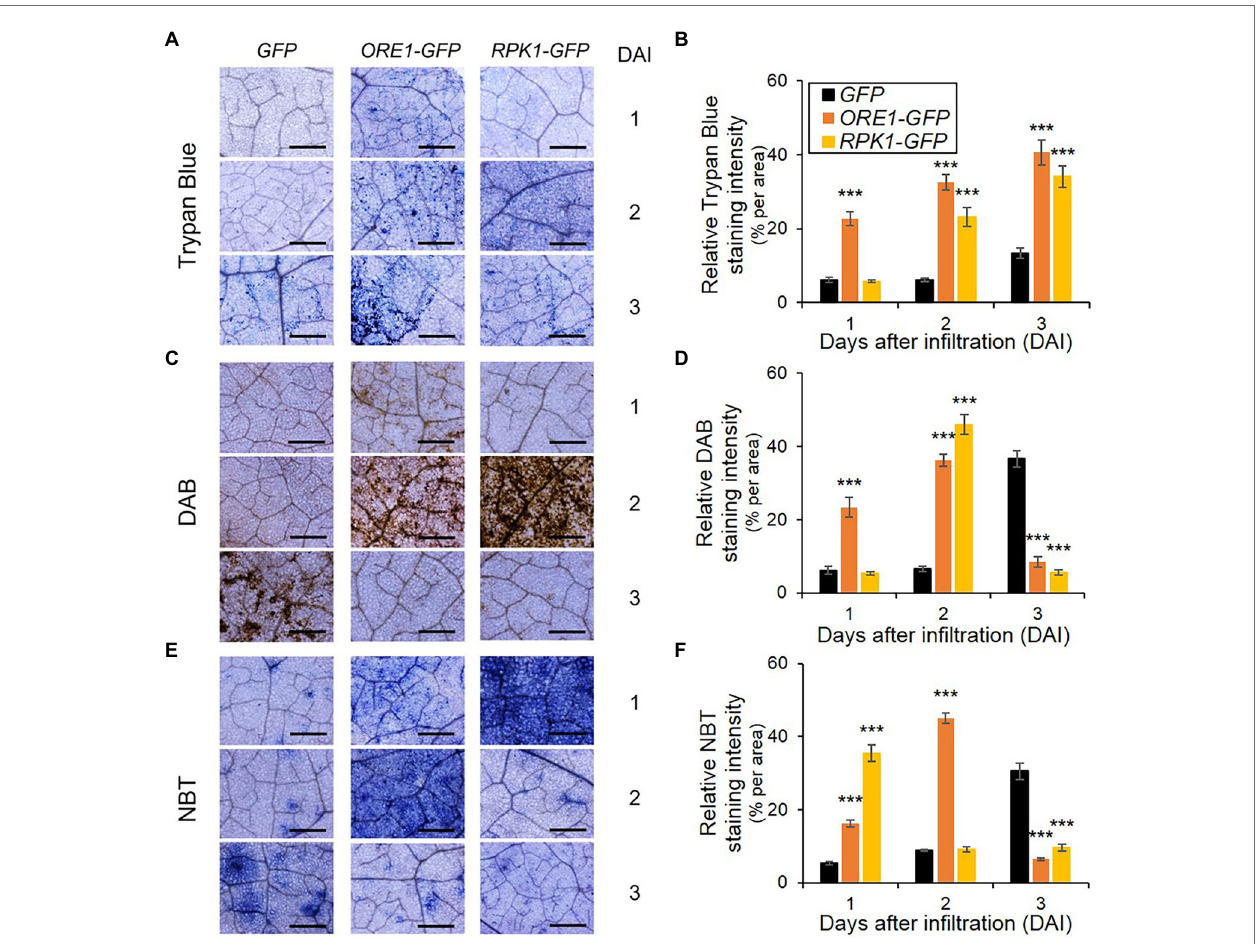
FIGURE 5 | ROS accumulation and cell death responses in Nicotiana benthamiana leaves expressing senescence regulators. (A,C,E) Representative images of leaves stained using trypan blue (A) , DAB (C) , and NBT (E) at indicated days after infiltration (DAI). GFP (Control), ORE1-GFP , or RPK1-GFP were transiently overexpressed in four-week-old N. benthamiana leaves through Agrobacteria infiltration. Subsequently, staining was conducted using their leaves on indicated DAI. Bars = 100 mm. (B,D,F) Time-series quantification of staining intensity from trypan blue (B) , DAB (D) , and NBT (F) images. Data represent mean ± SE ( n = 5). Statistical analysis was conducted using a two-tailed Student’s t -test (*** p < 0.001), and similar results were obtained in three independent